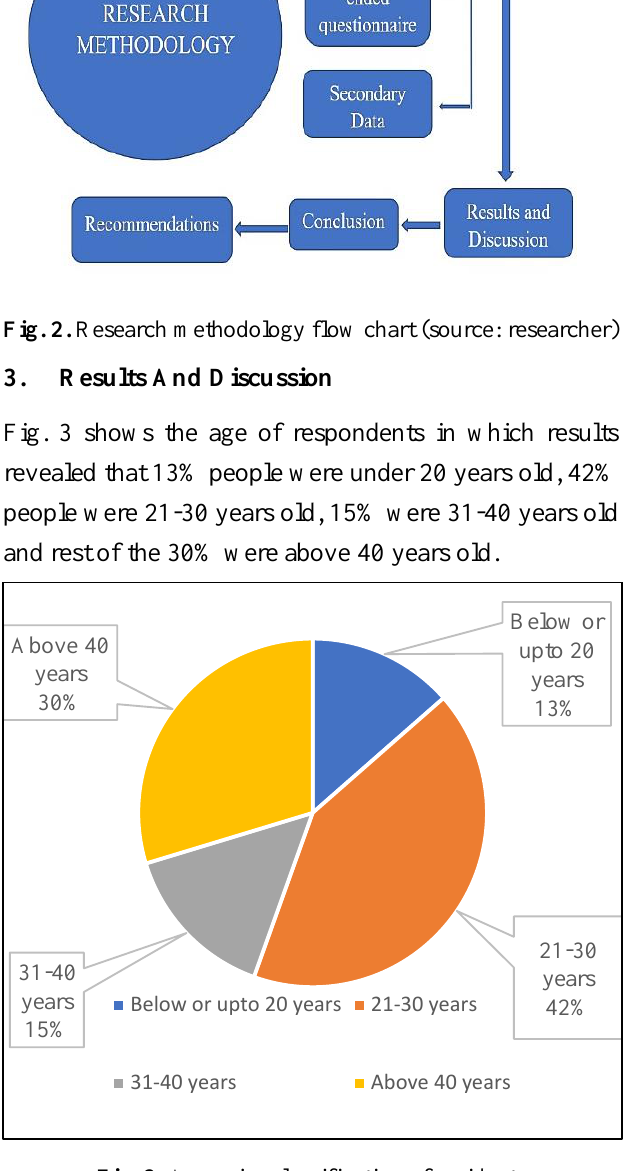
Fig. 3. Age-wise classification of